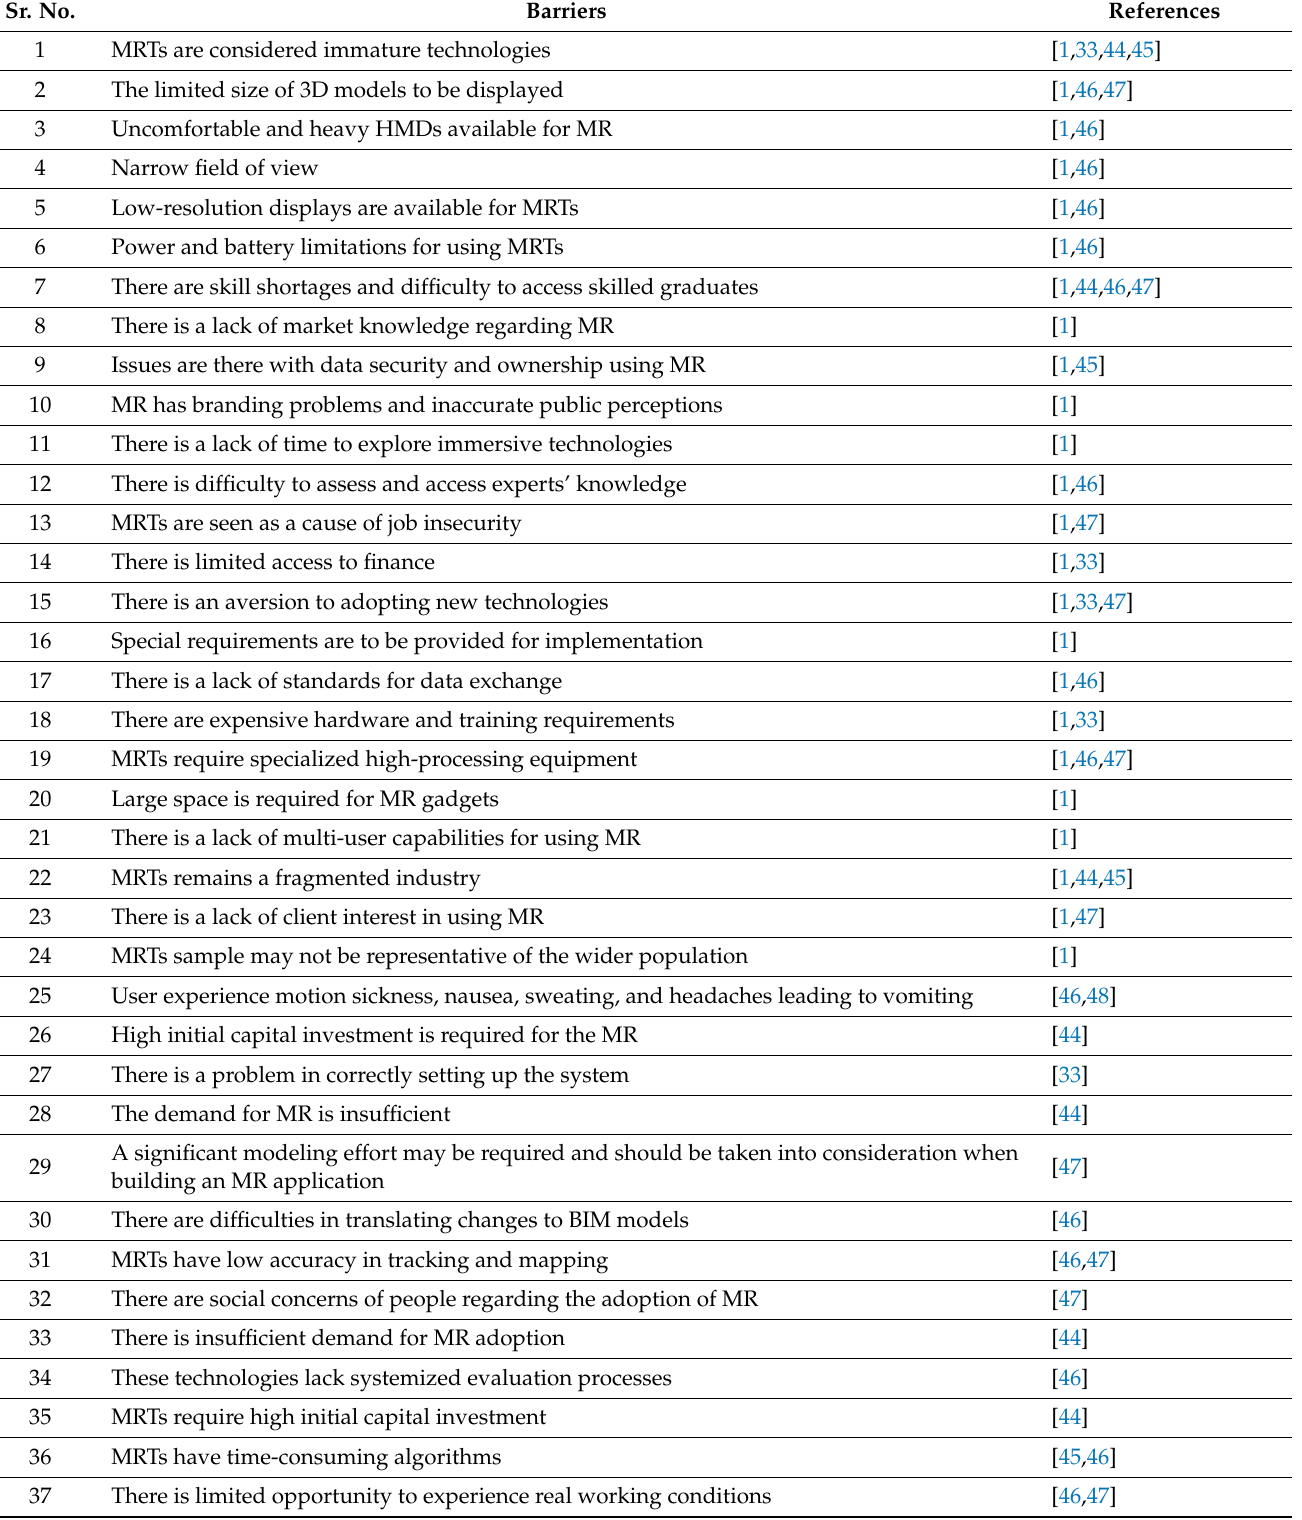
Table 1. Barriers to MR adoption in construction